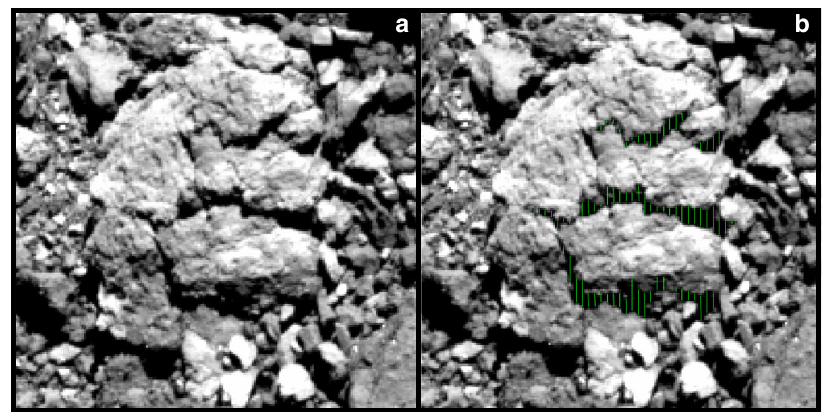
Fig. 5 Shadow length measurements. Example of a the thickness of exfoliation fl akes from Fig. 1e measured by b their shadow lengths (green lines) captured using